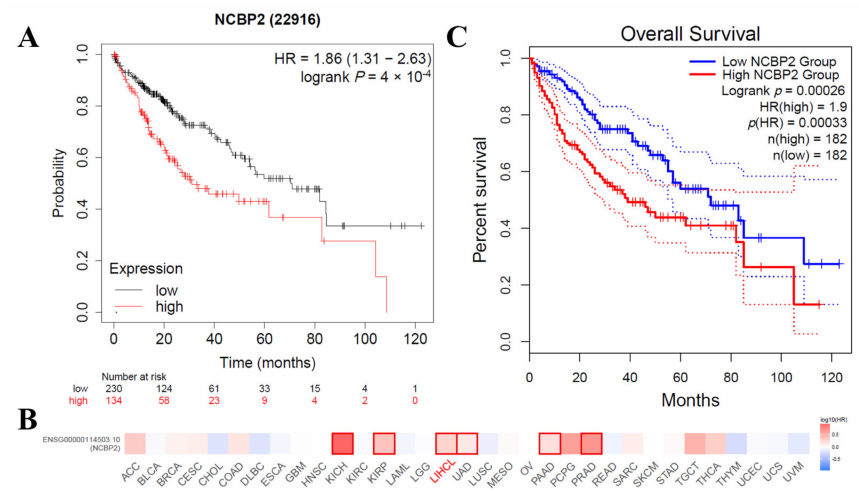
Figure 6. Kaplan–Meier survival curves comparing high and low expressions of NCBP2 in different databases. ( A ) Kaplan–Meier survival curves of LIHC in PrognoScan. ( B ) Relationship between NCBP2 expression and survival prognosis of each cancer in TCGA. ( C ) Kaplan–Meier survival curves of LIHC in Kaplan–Meier Plotter. Number at risk represent number of people exposed to outcome risk at each time point.